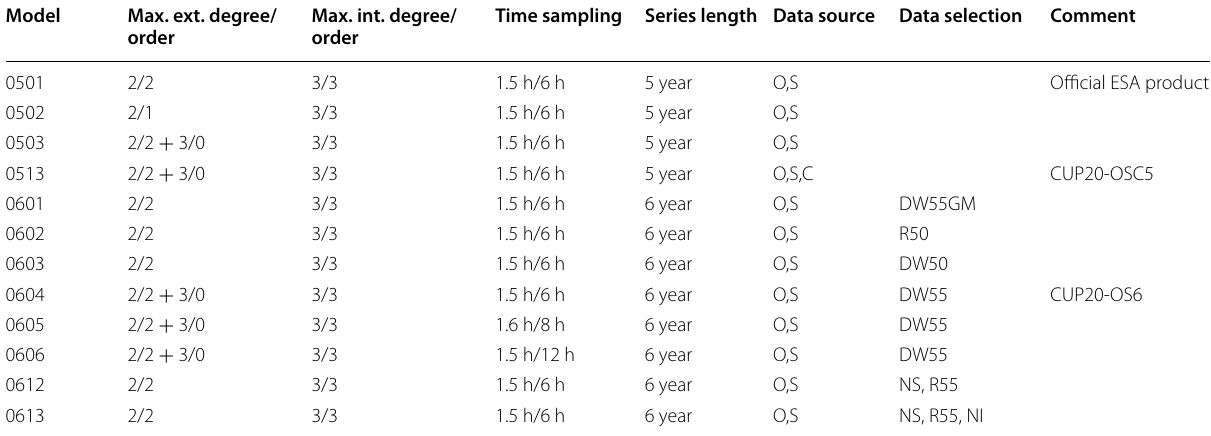
The datasets vary by the truncation degree and order of the external field, time sampling (the first value corresponds to the external and internal dipole terms 1/0, the second value to all other terms), the length of series, the inclusion of observatory, Swarm, and CryoSat-2 data (O, S, and C, respectively), and data selection. DW55GM: data polewards of dipole latitude 55 ◦ down-weighted by sin (ϑ GM )/ 100 ; DW50, DW55: data polewards of dipole latitude 50 ◦ or 55 ◦ down-weighted by sin (ϑ GC )/ 100 ; R50, R55: data polewards of dipole latitude 50 ◦ or 55 ◦ removed, NS: only night-side data, when the Sun is at least 10 ◦ below horizon are used; NI: the comprehensive model of the ionosphere is not subtracted from data. ϑ GM and ϑ GC stand for geomagnetic (dipole) and geocentric colatitudes, respectively